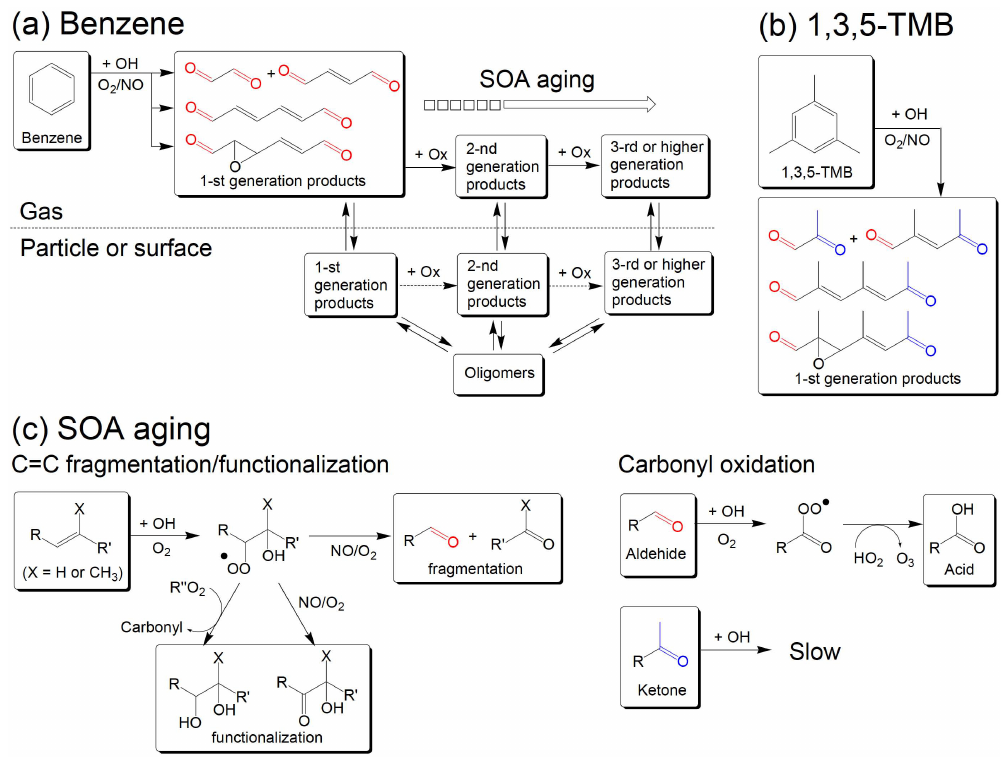
Fig. 3. Reaction schemes of (a) SOA formation from benzene photooxidation, (b) SOA formation from 1,3,5-trimethylbenzene photooxi- dation, and (c) SOA aging. A probable pathway to form each depicted product is only shown for simplicity; caroboxylic acid can also be produced by the heterogeneous decomposition of peroxyacyl nitrates (PANs) from the acyl peroxy radical + NO 2 reaction (Surratt et al., 2010); hydroxycarbonyl produced by functionalization can also be formed by the reaction of hydroxy peroxy radical with R 00 O 2 ; hydroxy peroxy radical of the intermediate of fragmentation/functionalization can also react with HO 2 ; and acylperoxy radical of the intermediate of carbonyl oxidation can also react with NO or RO 2